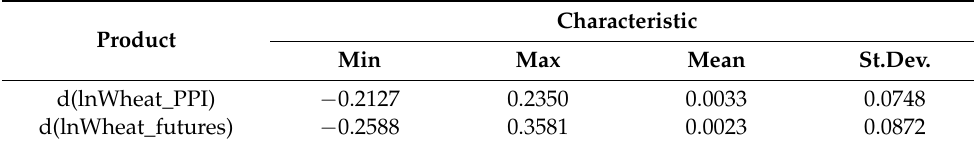
Table 1. Stationarity tests of logarithmic cash and futures prices of wheat in the USA.